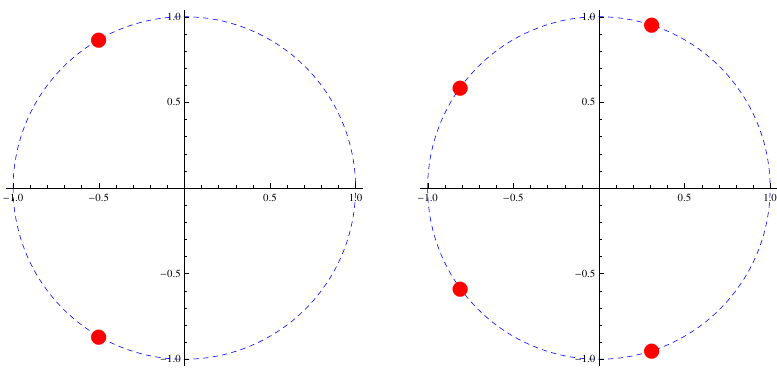
Figure 4 . The eigenvalues of the fundamental Polyakov loop. Left panel: su (2) with two fun- damental and two adjoint fermions. Right panel: su (4) with two fundamental and two adjoint fermions. In both cases we (cid:12)nd tr F (cid:10) = (cid:0) 1. Since the trace is real, the unique vacuum of these theories respects C , P , and T